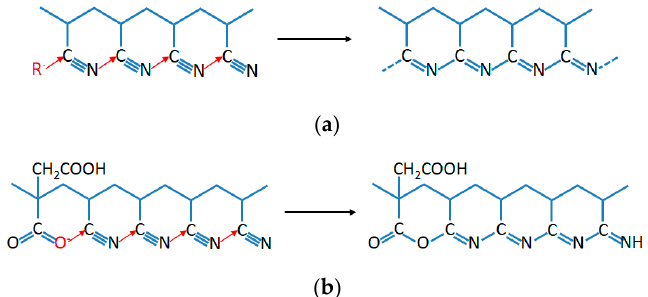
Figure 6. Cyclization reaction: ( a ) the free radical mechanism and ( b ) the ionic mechanism.